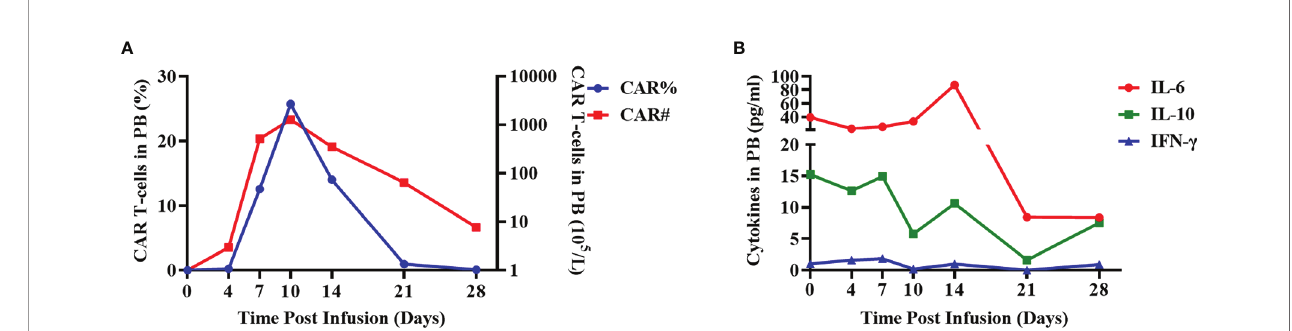
FIGURE 2 | Evaluation of CAR ratio, the number of CAR-T cells and cytokines in the peripheral blood. (A) The ratio of BCMA CAR-T cells in total lymphocytes (CAR %) and the absolute number of BCMA CAR-T cells (CAR#) in the peripheral blood of the patient were detected using fl ow cytometry at the indicated days after CAR- T infusion. (B) The expression levels of cytokines (IL-6, IL-10, and IFN- g ) in the peripheral blood were evaluated using cytometric bead array after CAR-T infusion at the indicated time points.